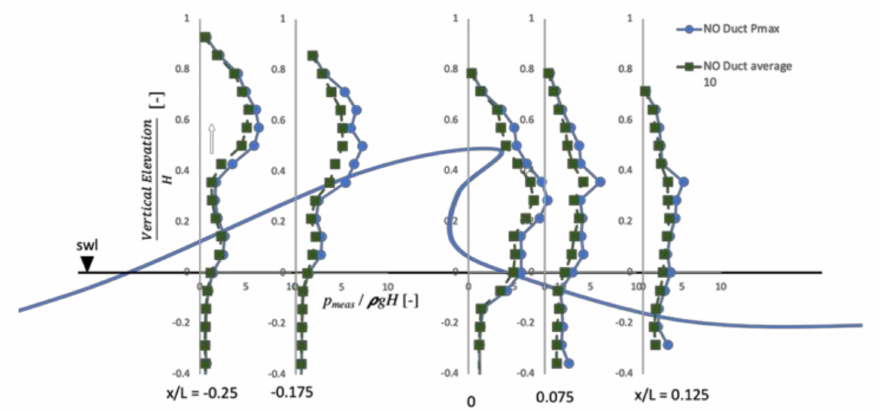
Figure 12. Pressure measurements at various elevations and horizontal locations for the no duct case for maximum pressure measured (blue circle) and average of 10 highest pressures measured (green square). The simplified breaking wave image on the background is intended as a visual aid only and does not represent the actual breaking wave during